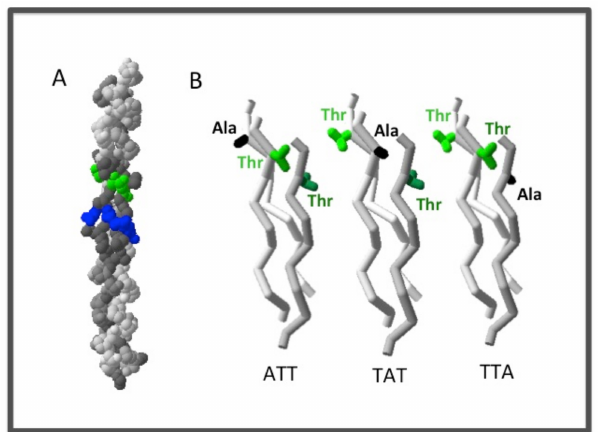
Figure 1. The rod-shaped conformation of the triple helix. ( A ) The structure of the homotrimer triple helix T73–785 [15] was generated using DeepView–Swiss-PdbViewer (PDB: 1bkv). The helix is shown with the N-terminus on top; the Thr residues are shown in green, Arg in blue, hydrophobic residues in dark gray. ( B ) In order to show the asymmetric structure of a heterotrimer associated with different chain registers, a type I collagen like the AAB heterotrimer model was created using DeepView by replacing the Thr of one of the three chains of 1bkv to Ala (side chain shown in black). The amino acid residues included in this heterotrimer model are ITGARGLAG for the two identical strands, and IAGARGLAG for the third, mutated strand. The three structures are shown in the identical view of the backbone, with the N-terminus on